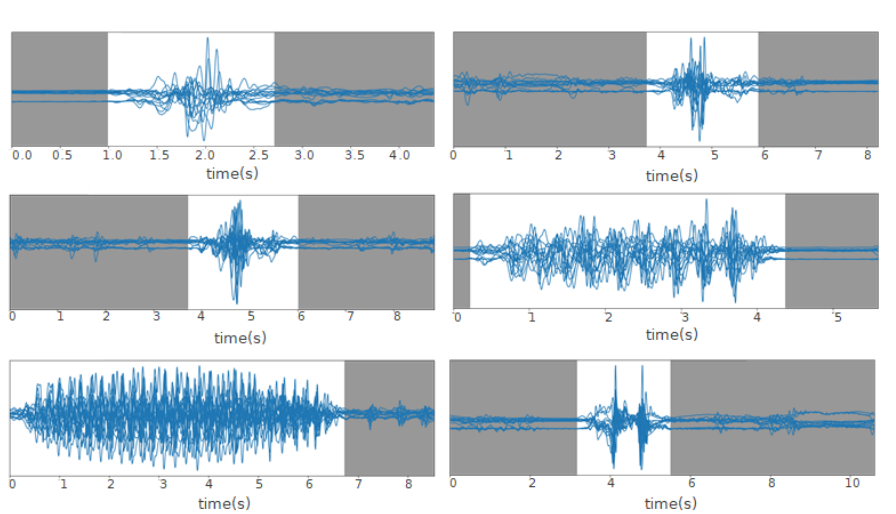
Figure 3. Examples of periods of high activity (white background) obtained after applying Algorithm 1. The examples show accelerometer data related to a shot, pass, pass, jog, sprint, and